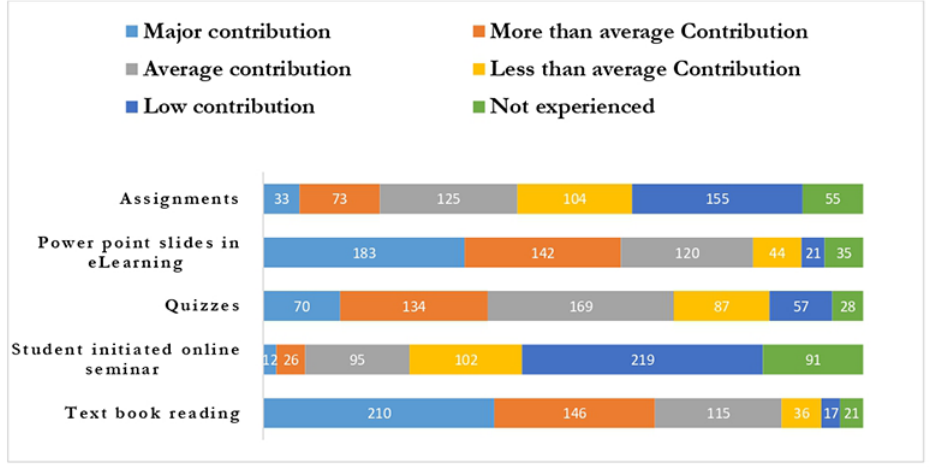
Figure 7. Preference of students towards variety of learning resources.